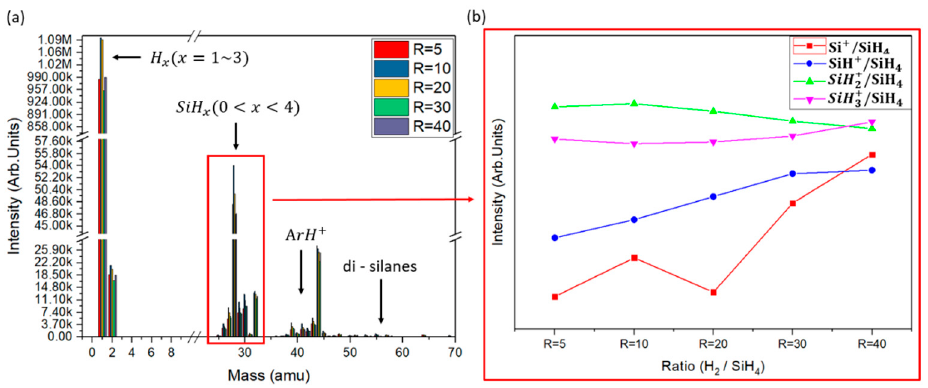
Figure 4. ( a ) Residual gas analysis (RGA) mass scan; ( b ) Threshold ionization mass spectrometry (TIMS) relative SiH x (1 < x < 4) densities.